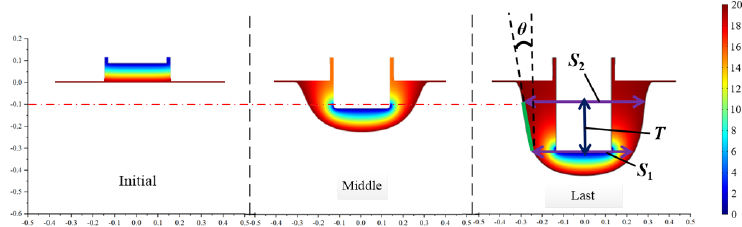
Figure 5. Simulation results for a conventional tool structure.